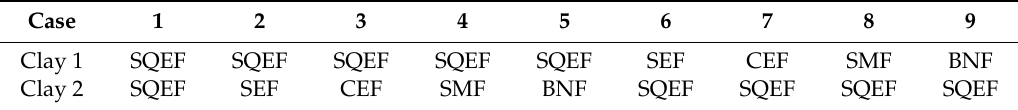
Table 3. Di ff erent cases for the study of the e ff ects of autocorrelation function